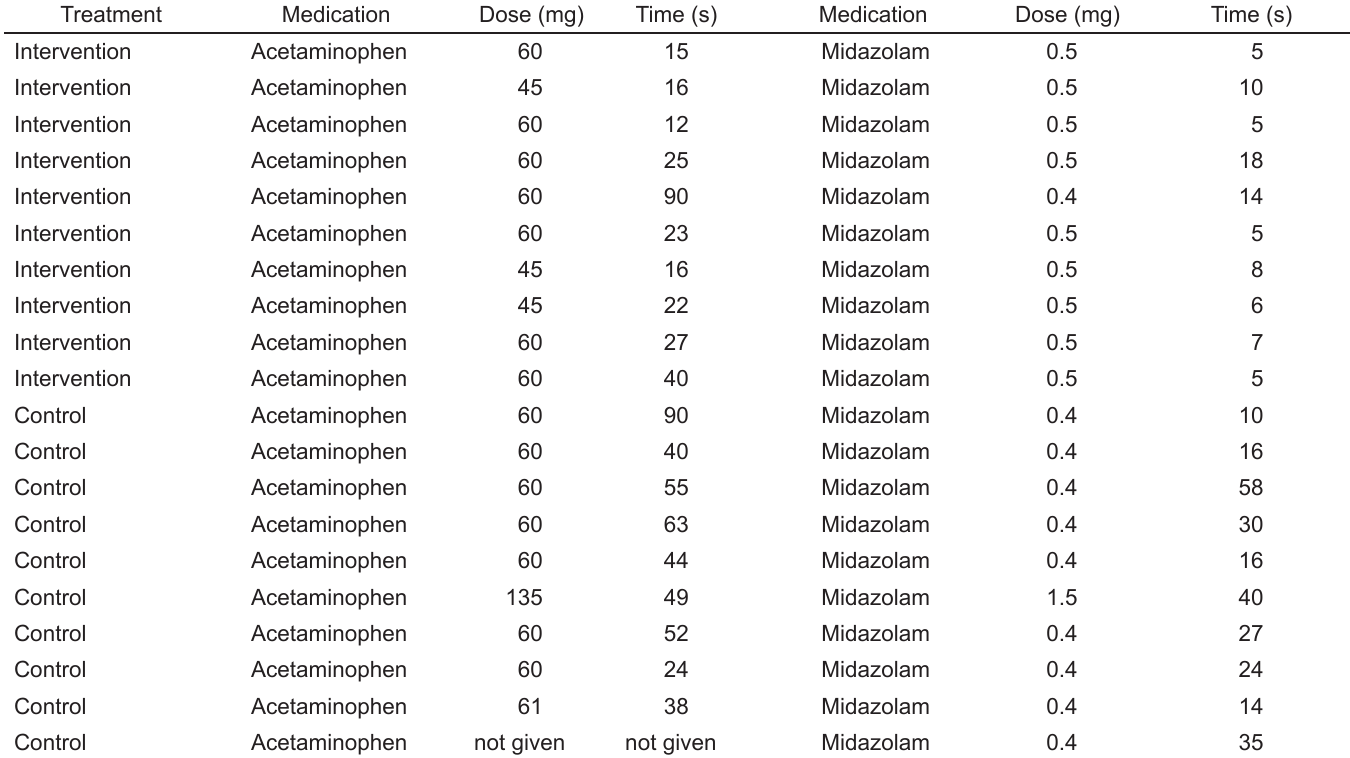
Table 2a. Case one - febrile seizure. Dose and time for each medication in each group.